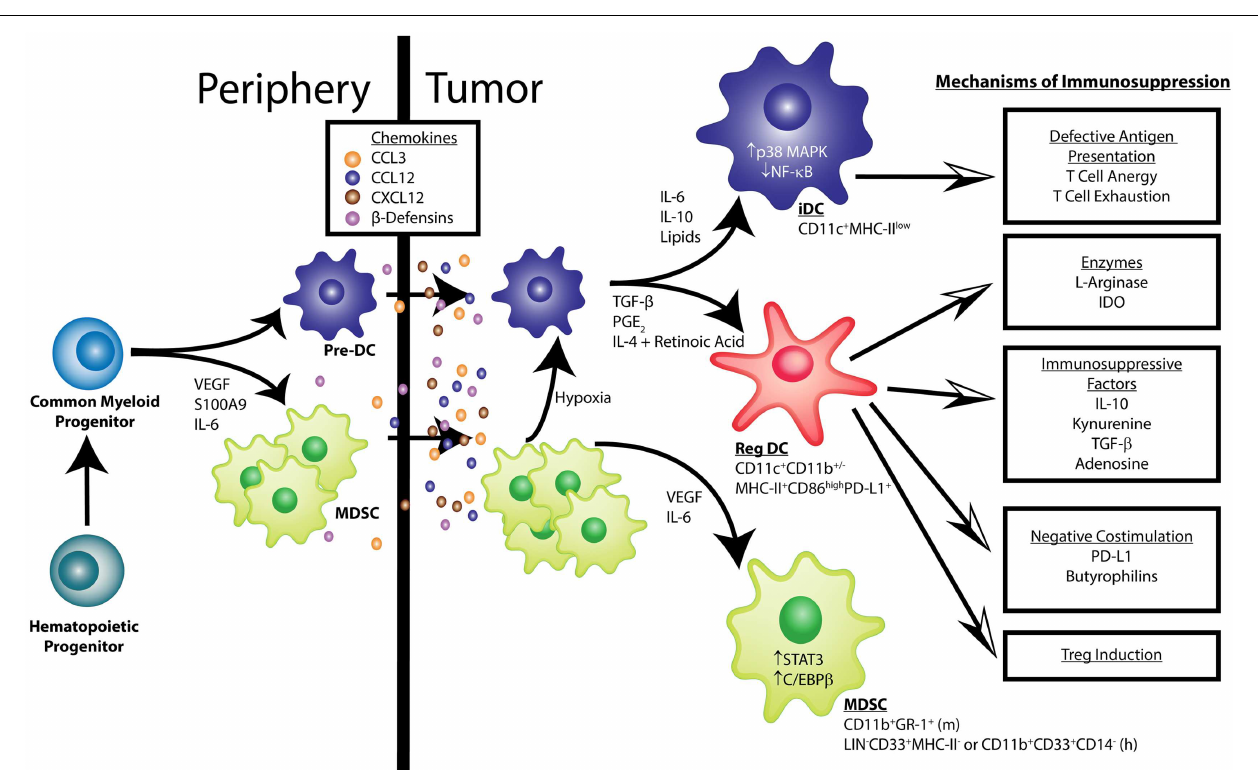
In other conditions, like those found in epithelial ovarian cancer, pre-DCs mature into cells that express markers of conventional DCs (CD11c + MHC-II + CD86 high ), but exert immunosuppressive functions, termed regulatory DCs (Reg DCs). Factors such asTGF- β , PGE 2 , IL-4, and retinoic acid have been shown to promote this altered maturation.These Reg DCs differ from conventional DCs in their ability to suppress effectorT cell function